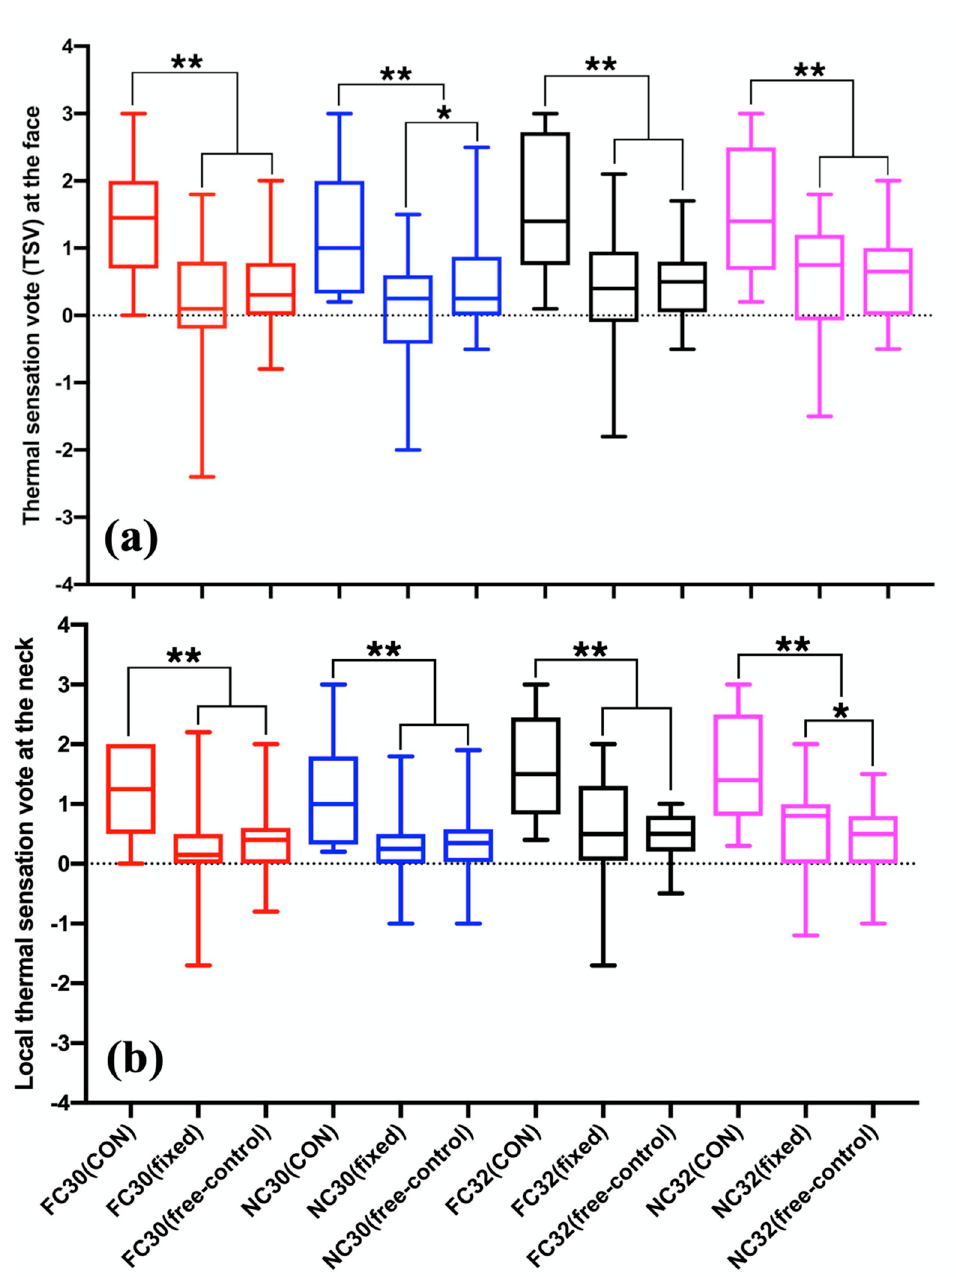
Figure 5. Local thermal sensation votes at ( a ) the face area and ( b ) the neck. *, p < 0.05; **, p <